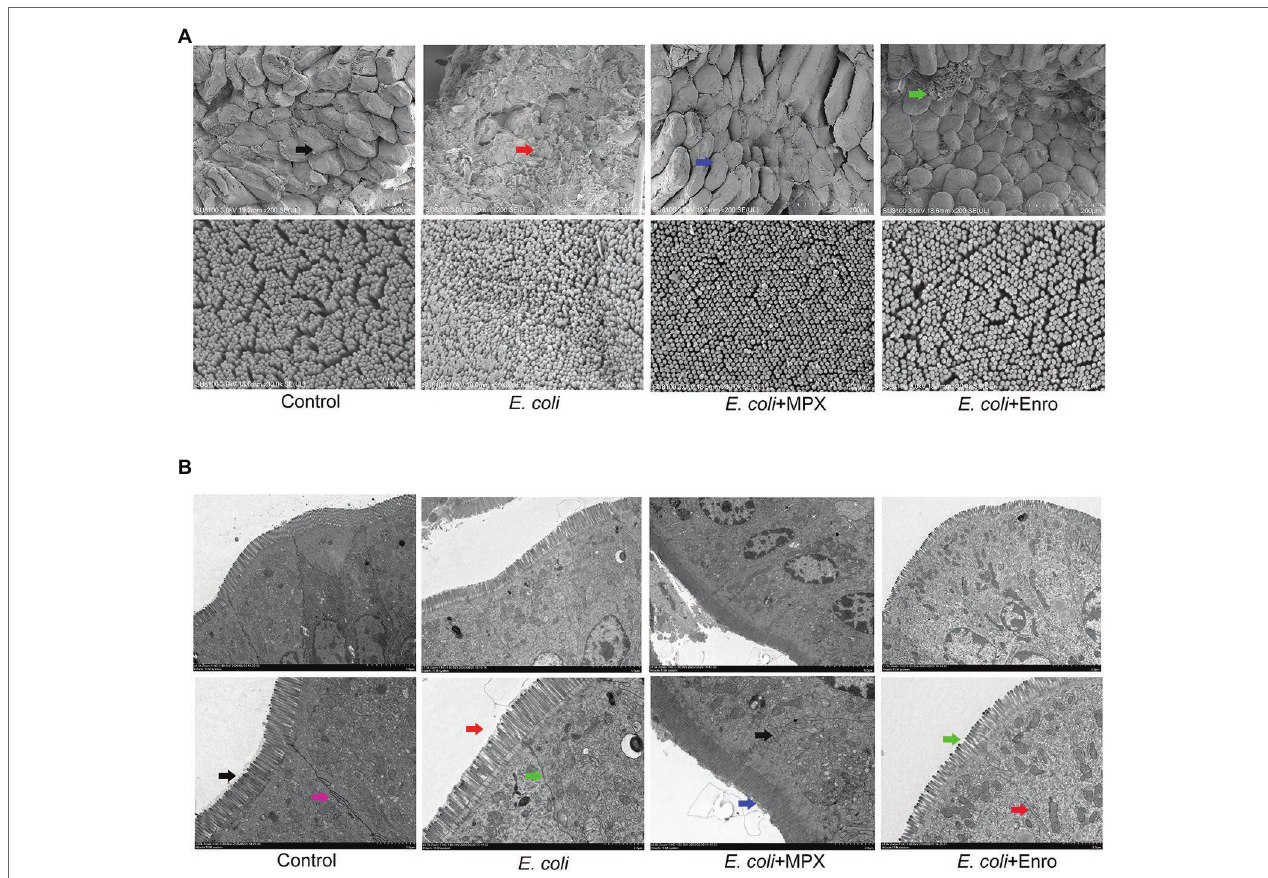
FIGURE 5 | MPX improves the intestinal morphology of the jejunum and the microvilli of intestinal epithelial cells. (A) Morphological changes in the jejunum villi were observed by SEM (upper, 200×; lower, 30,000×). (B) Morphological changes in the microvilli and tight junction proteins in intestinal epithelial cells were observed by TEM (upper, 1500×; lower,